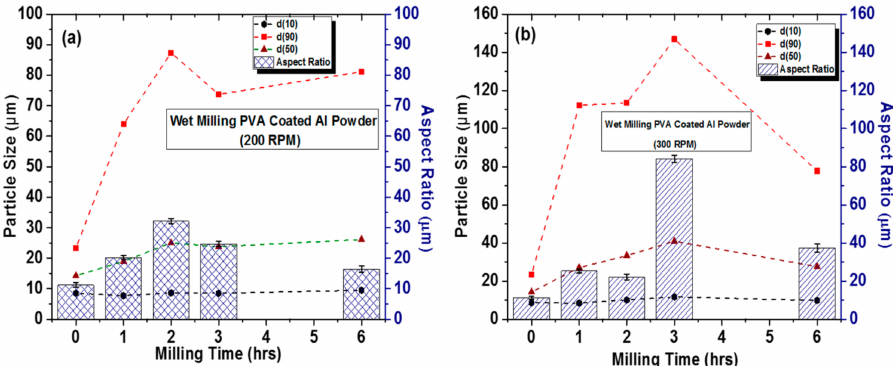
Figure 7. Particle size analysis with distribution size (D10, D50 and D90) of the ball milled powders at ( a ) 200 rpm and ( b ) 300 rpm vs. milling